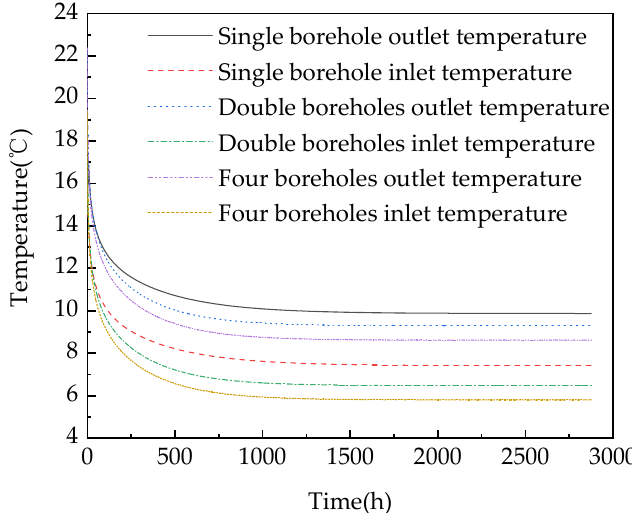
Figure 7. Changes in the inlet and outlet temperatures in winter.